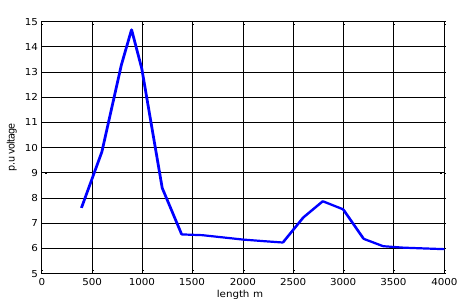
Fig. 24. Maximum instantaneous overvoltage for phase-c secondary to the base of cable length.